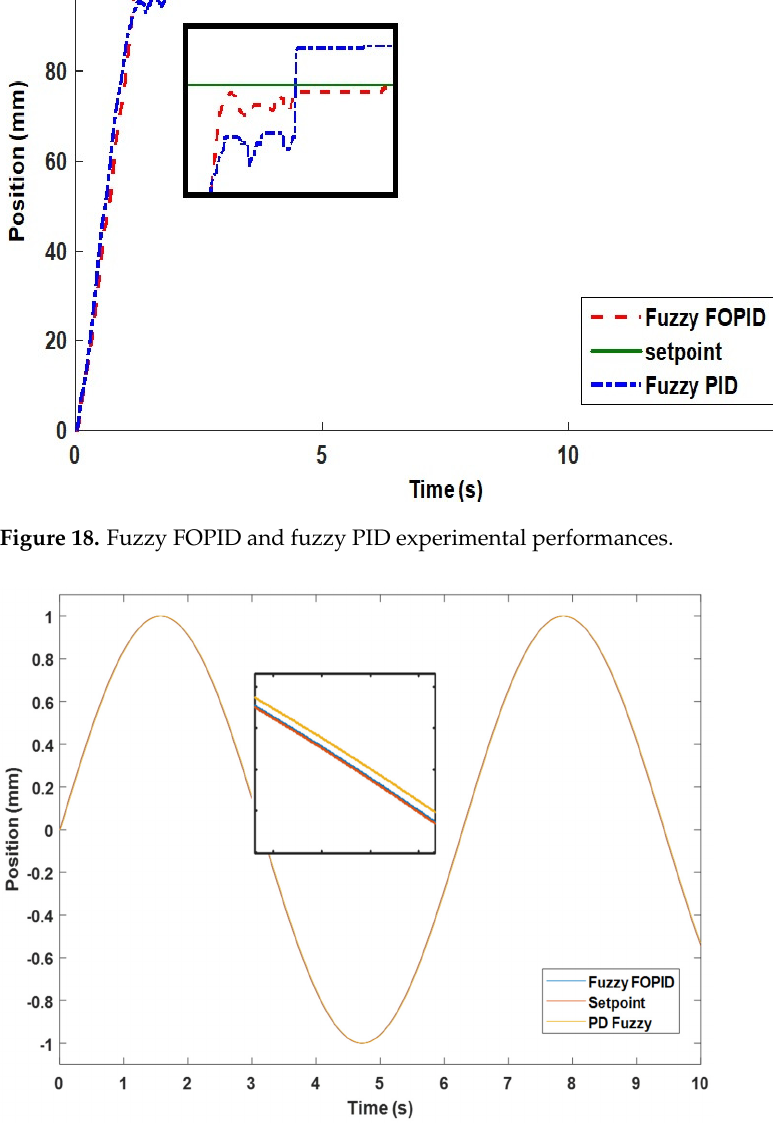
Figure 19. Simulation performances for the IPA with sinewave input. Table 5. Comparison between fuzzy PID and fuzzy FOPID performances (Fixed at 100